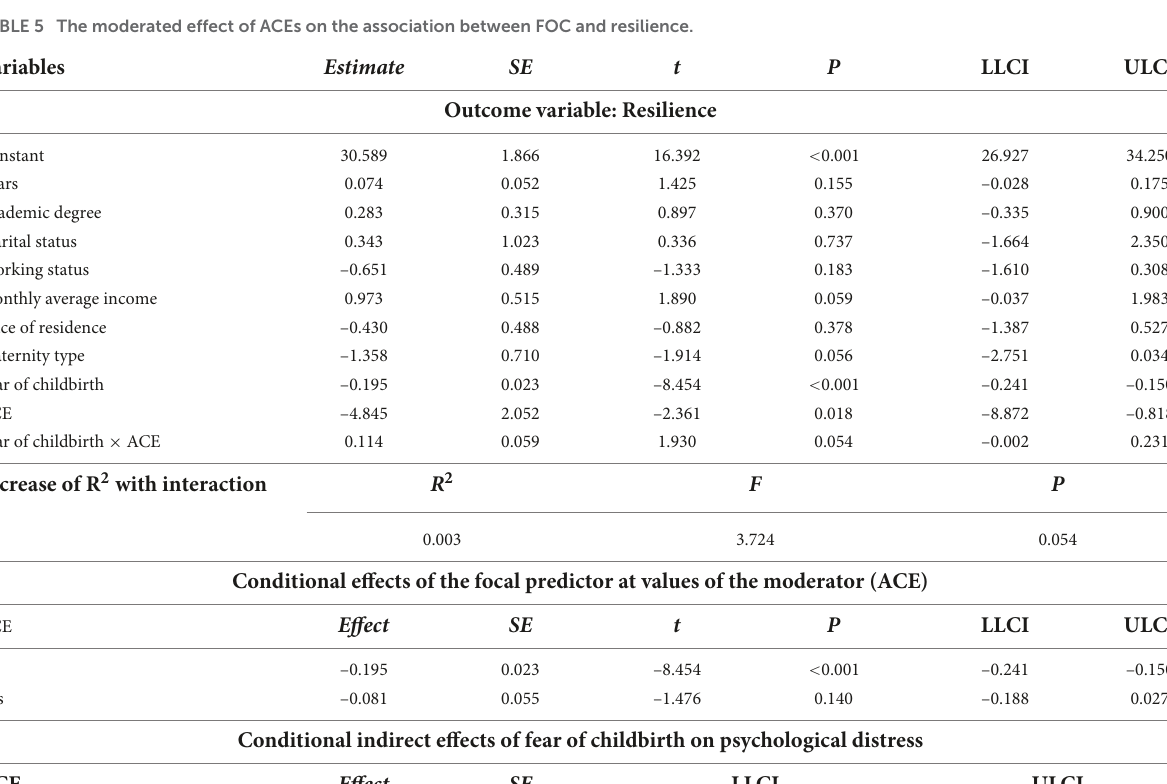
TABLE 5 The moderated effect of ACEs on the association between FOC and